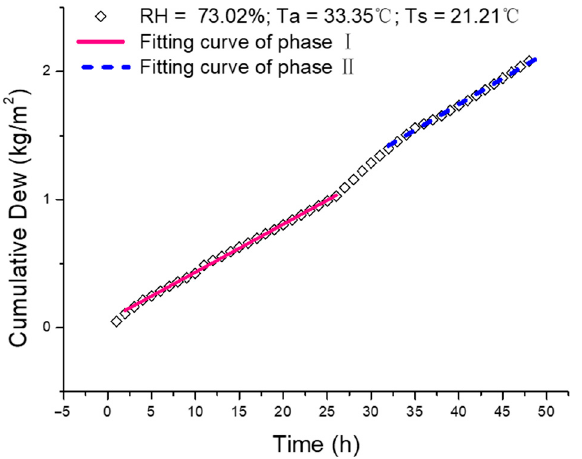
Figure 6. The mass increases of samples are composed by two phases. Both phases were treated linearly to calculate the dew formation rate N .